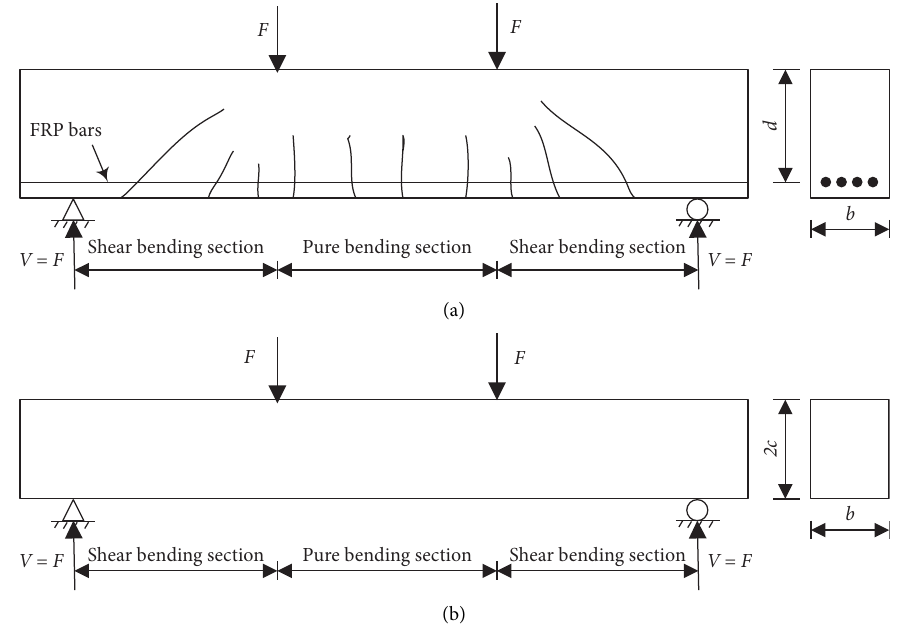
Figure 1: Transition of the FRP bar reinforced concrete beam to the ideal elastic material beam. (a) FRP reinforced beam. (b) Equal ideal elastic material beam.